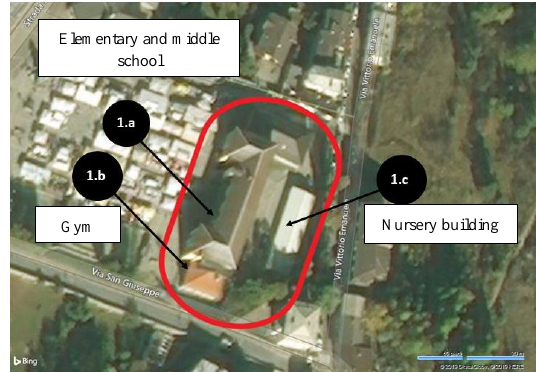
Figure 4. Buildings involved, source: www.bing.com/maps.